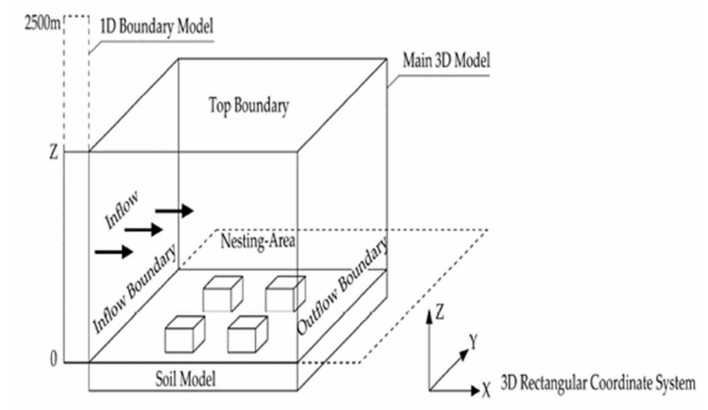
Figure 3. Architecture of software model ENVI-met